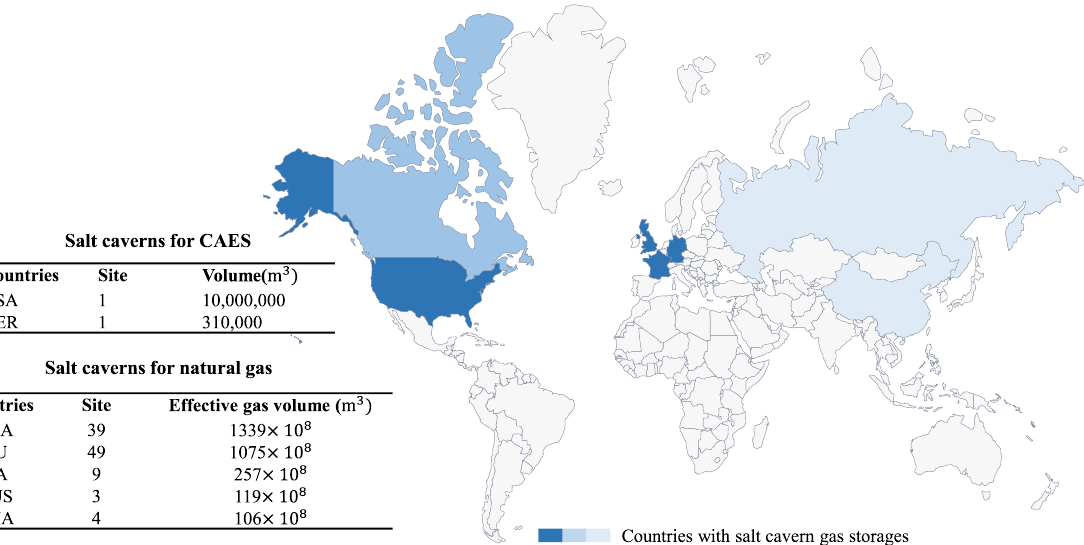
Figure 2. Current situation of underground salt cavern energy storage and utilization in the world [32].